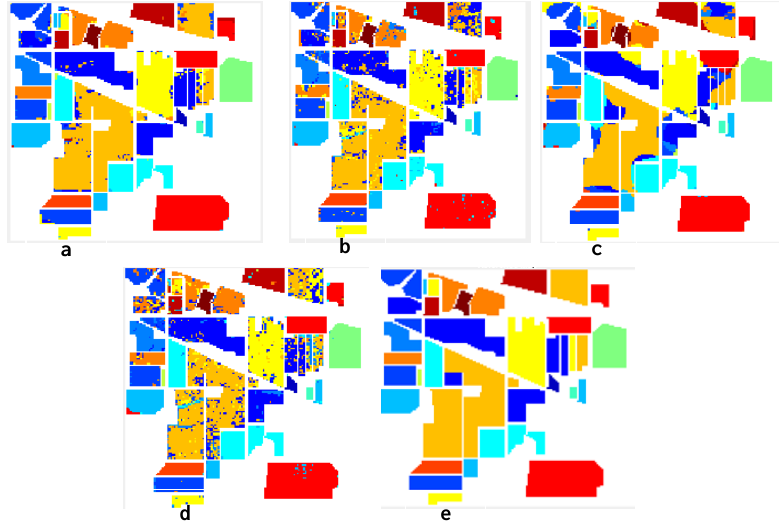
Figure 8. Classification maps for Indian Pines: (a) proposed, (b) LBG, (c) 3D-Gabor, (d) Stacking and (e) GTM